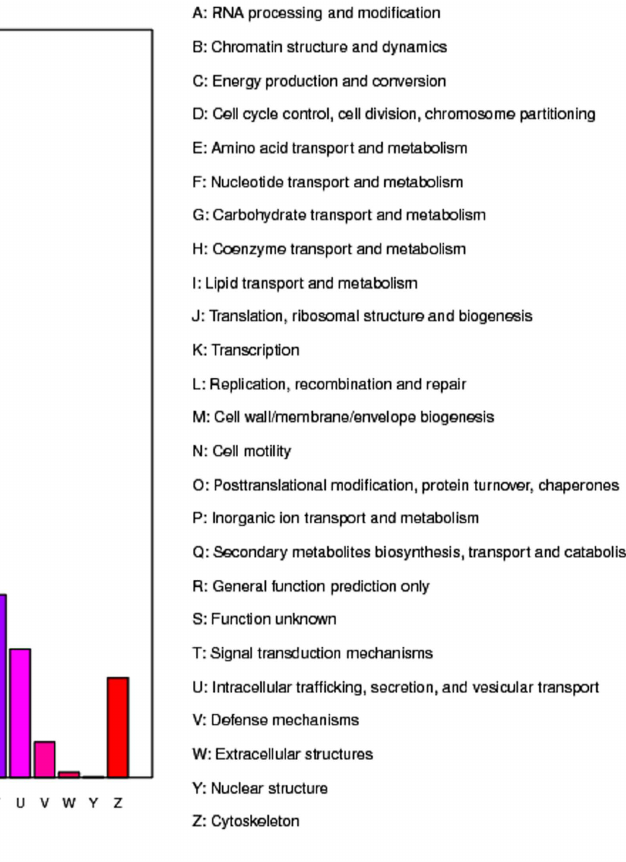
Figure 2. COG annotations of putative proteins. All putative proteins were aligned to the COG database and can be classified functionally into at least 25 molecular families.